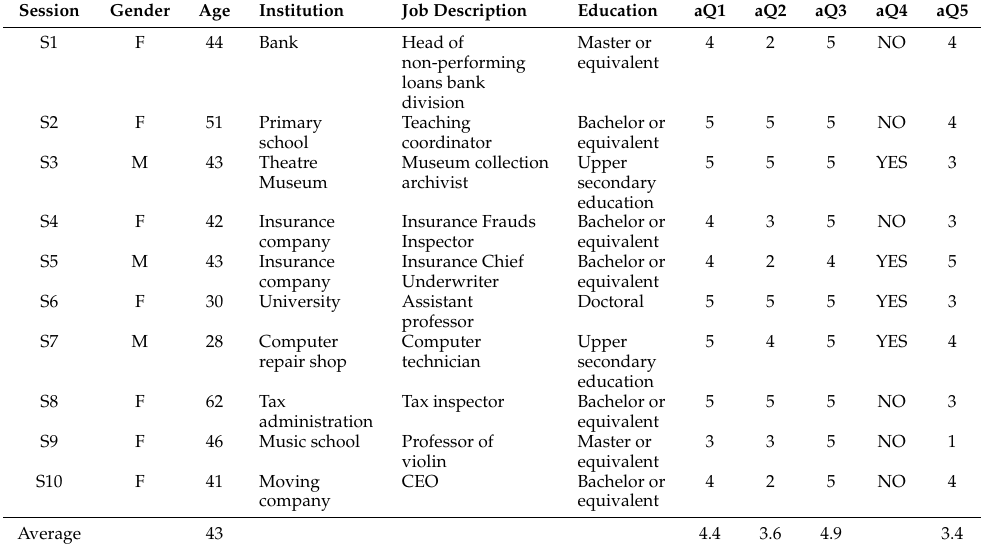
Table 2. Background questionnaire results. Education level is based on International Standard Classification of Education (ISCED)